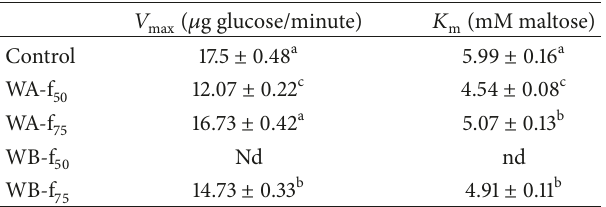
Table 4: Inhibition kinetics of water extractable arabinoxylans derived from Lineweaver–Burk